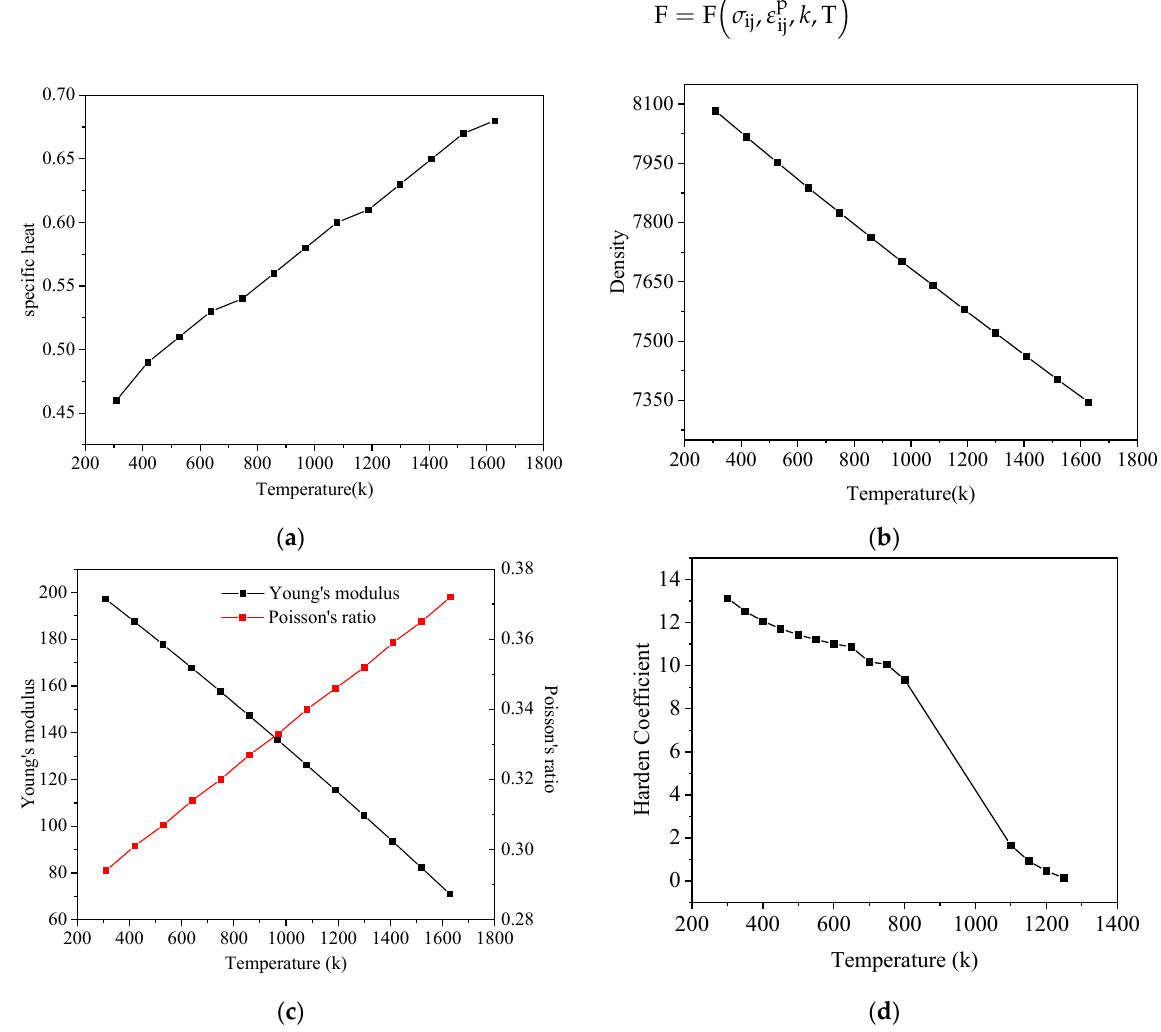
Figure 1. Physical parameters: ( a ) Specific heat coefficient; ( b ) density coefficient; ( c ) Young’s modulus and Poisson’s ratio; and ( d ) Hardening coefficient.